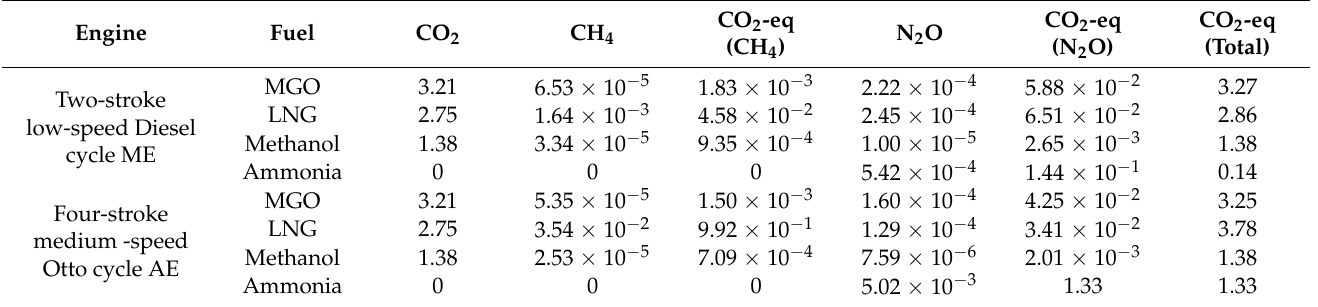
Table 7. The CO 2 equivalent emission factors (ton/ton fuel) of the